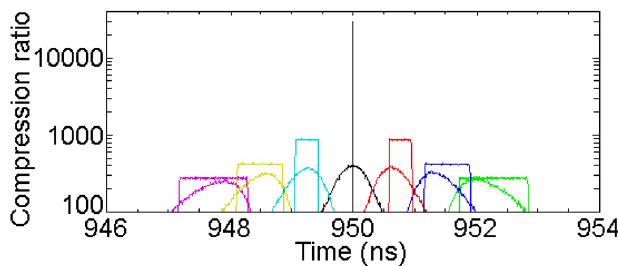
(cid:2) t (cid:3) =I (log scale) compari- b 0